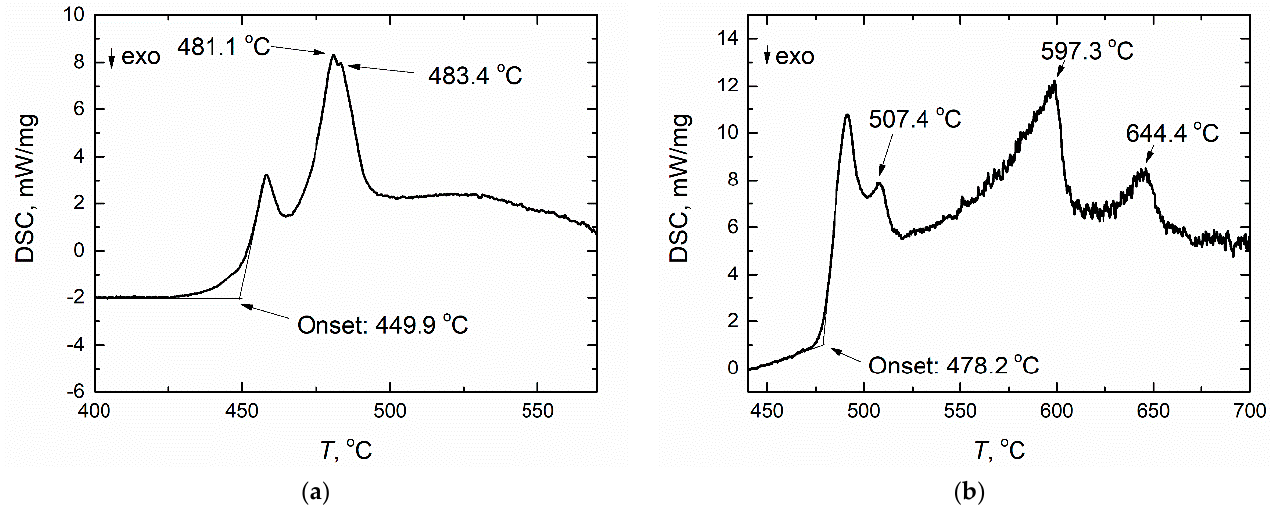
Figure 7. The DSC heating curves obtained ( a ) in the FLiNaK + 6 mol% NdF 3 ; ( b ) in the FLiNaK + 26 mol% NdF 3 ( b ).